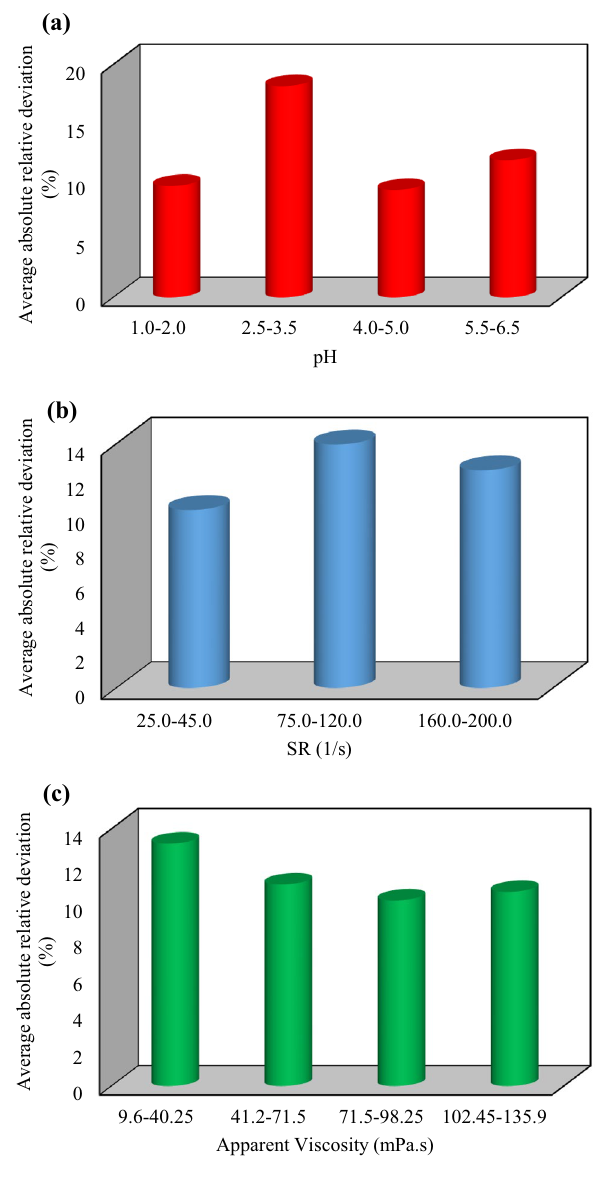
Fig. 7 The average absolute relative deviations (%) associated with the proposed GEP model at different ranges of a pH, b shear rate, and c the VES-based acid